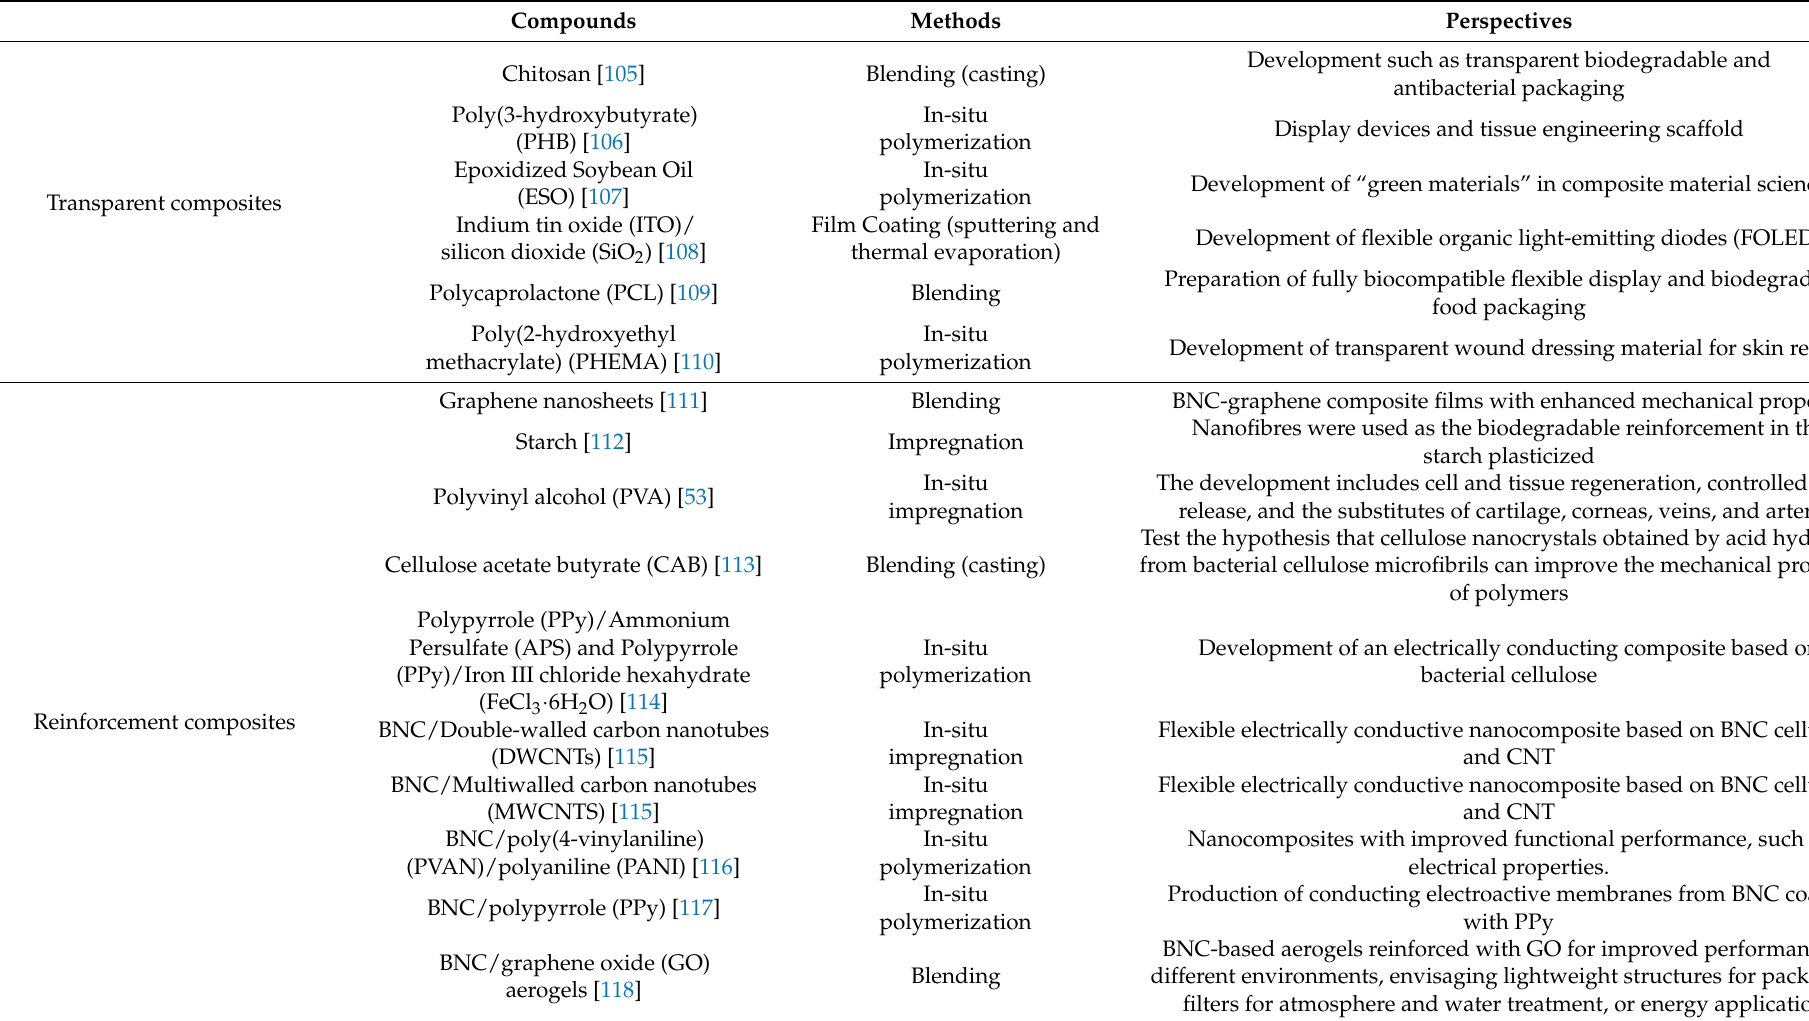
Table 2. BNC-based nanocomposites with improved transparency and mechanical reinforcement for different